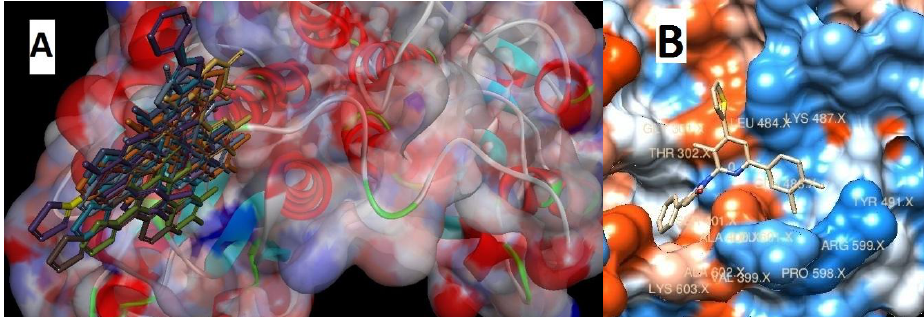
Table 1. In silico molecular docking results of the synthesized compounds ( 1 – 15 ).